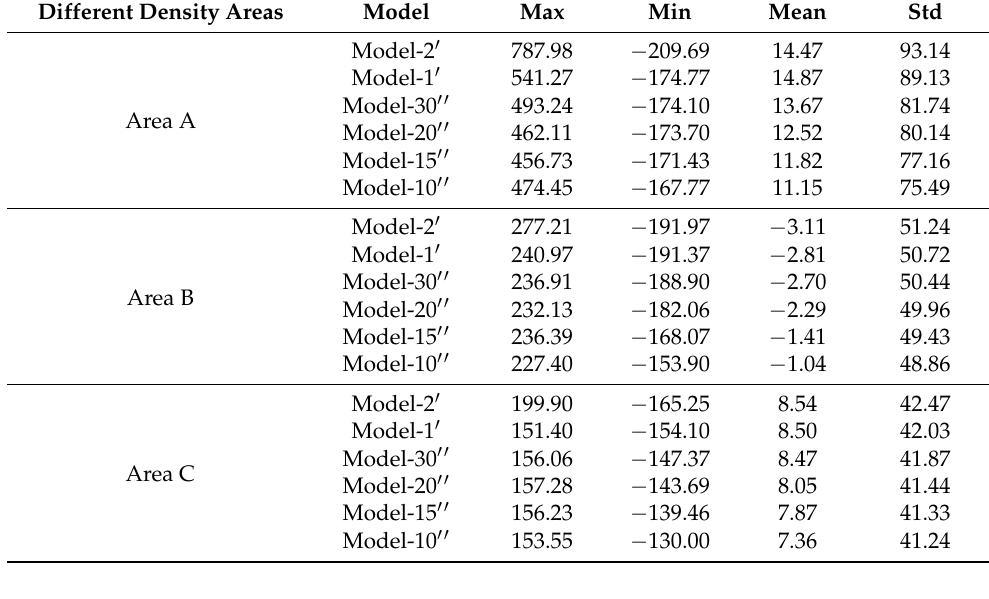
Table 7. Statistics of difference data of terrain model check points in different density areas (m). Different Density Areas